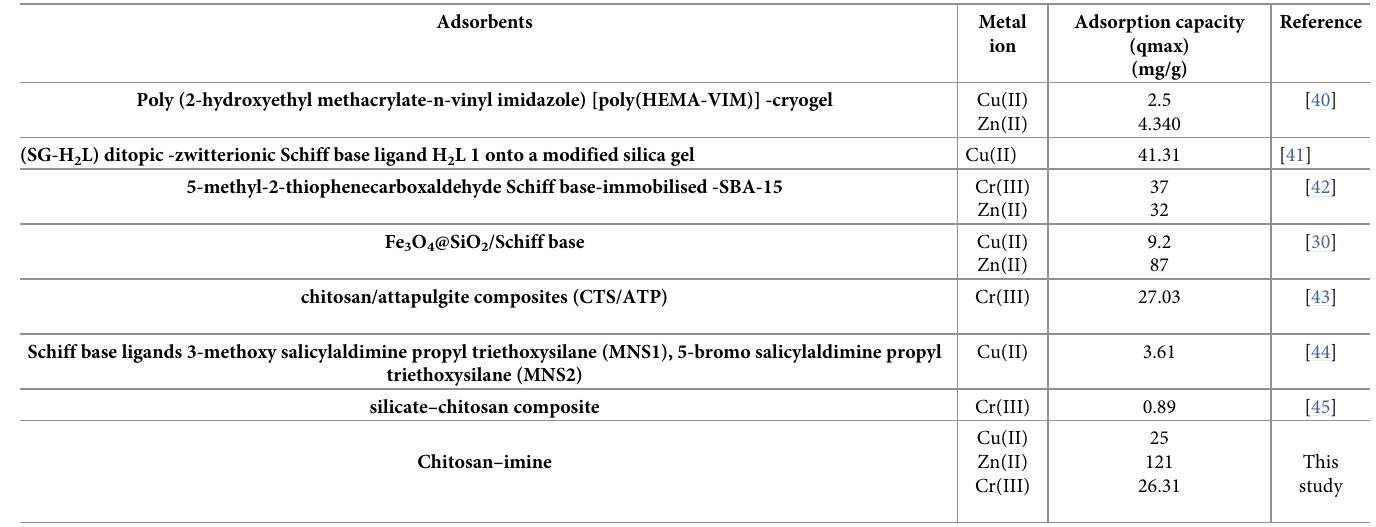
Table 6. Comparison of Cu(II), Zn(II) and, Cr(III) adsorbent in different adsorbents materials. Adsorbents Metal